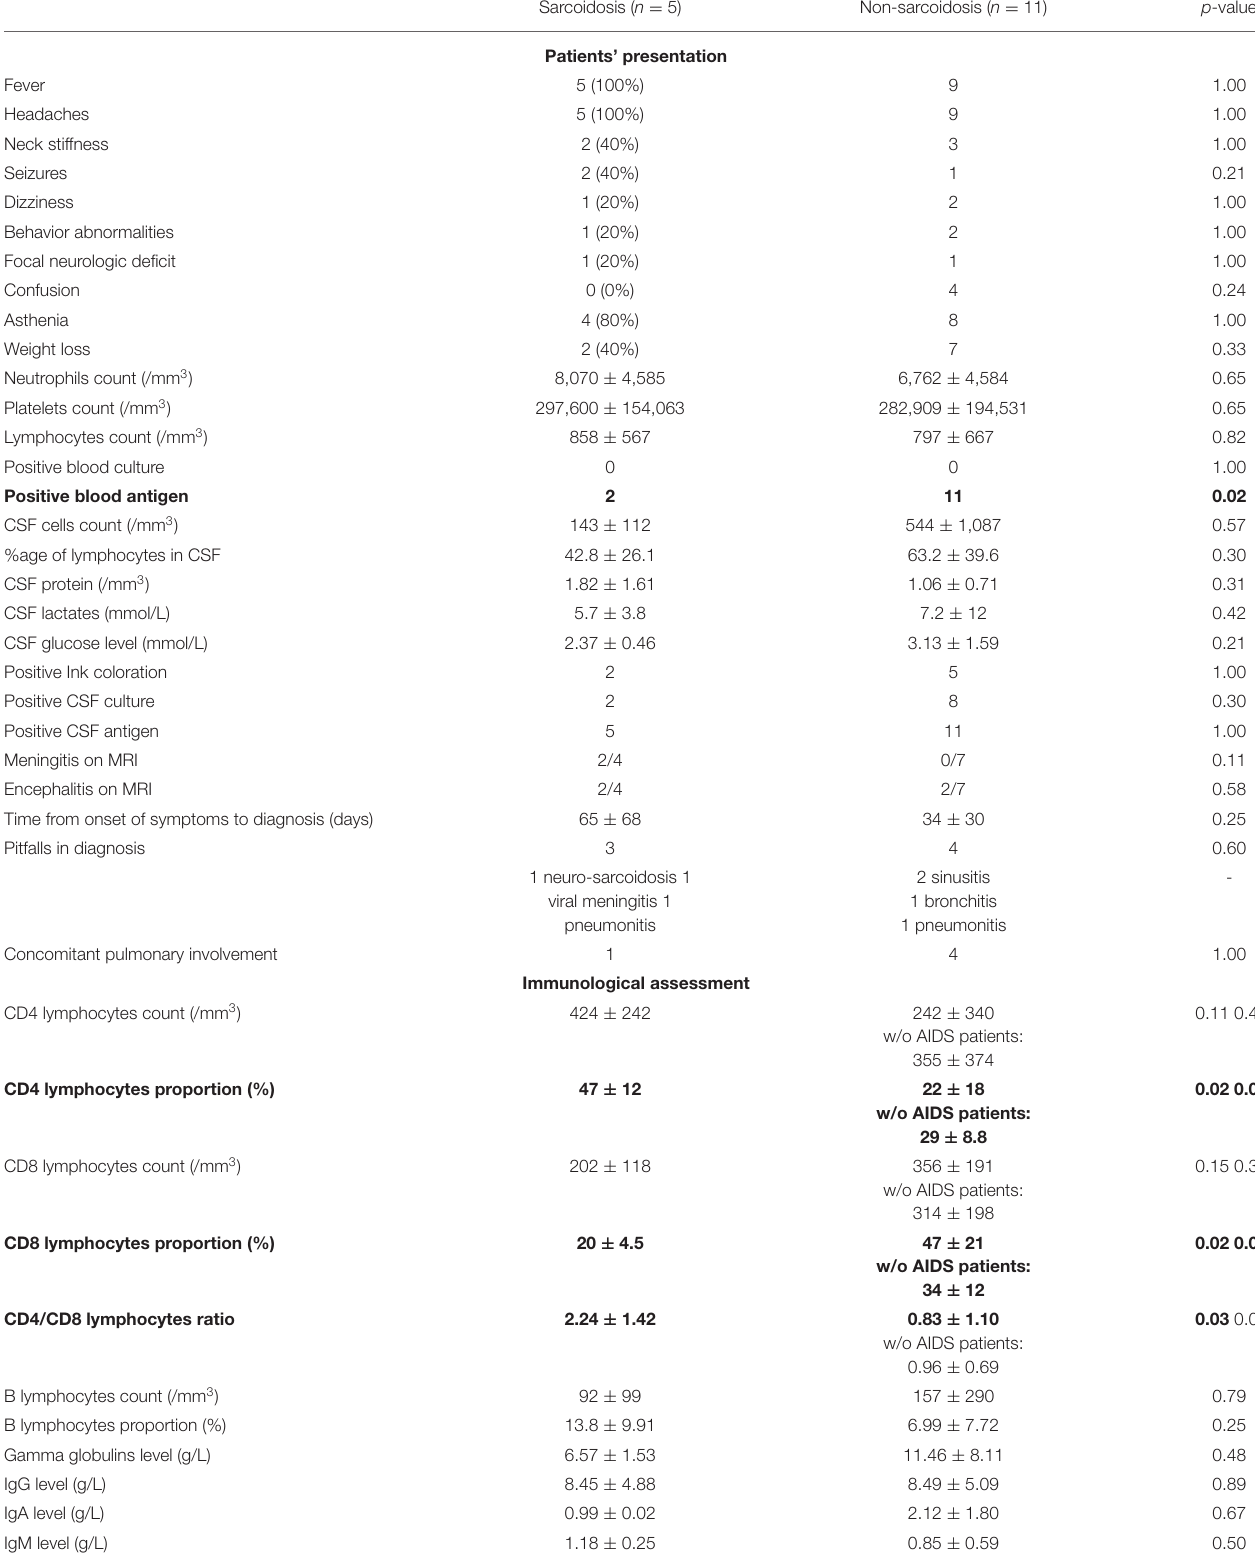
TABLE 2 | Patients’ presentation and immunological assessment at diagnosis of Cryptococcus spp. infection of central nervous system. Sarcoidosis ( n = 5) Non-sarcoidosis ( n = 11) Patients’